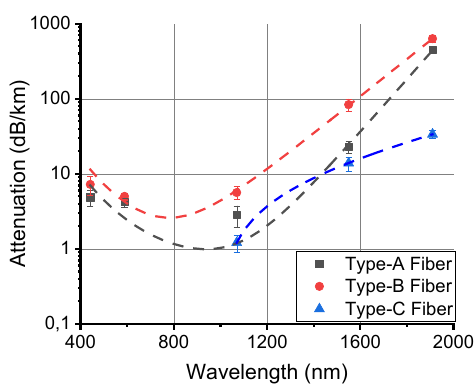
Fig. 2. Spectral dependence of optical loss for the three fibers under test (semi-logarithmic